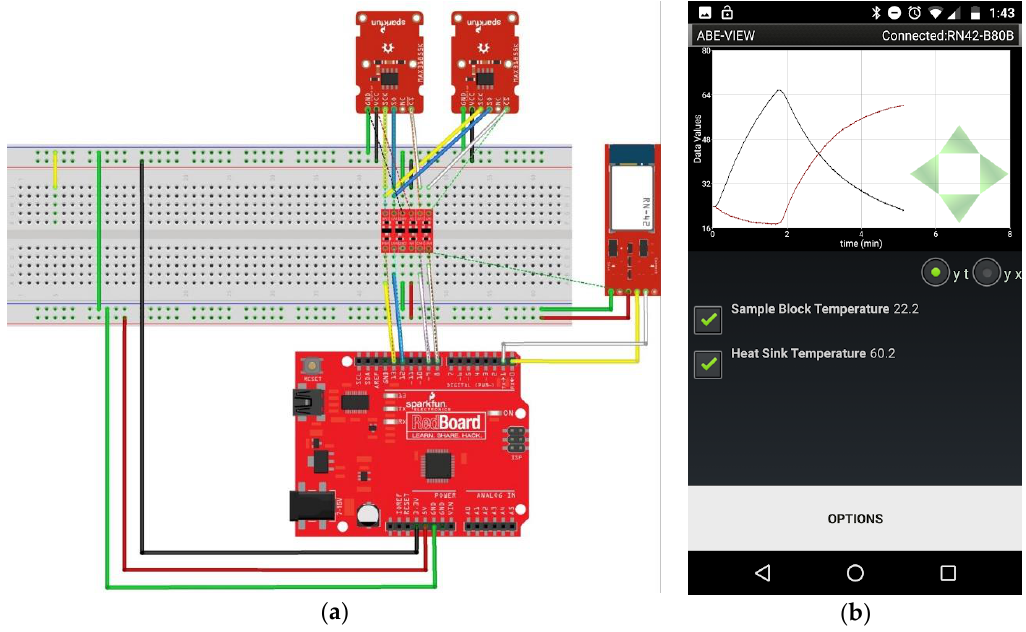
Figure 6. ( a ) Data acquisition system assembled by students using off the shelf components (Sparkfun RedBoard, BlueSMiRF Silver, 2 MAX31855 thermocouple breakout boards with type K thermocouple, and bi-directional logic level converter) to record the dynamic performance of a thermal cycler with a student designed heat sink, and; ( b ) student populated ABE-VIEW interface for data acquisition.